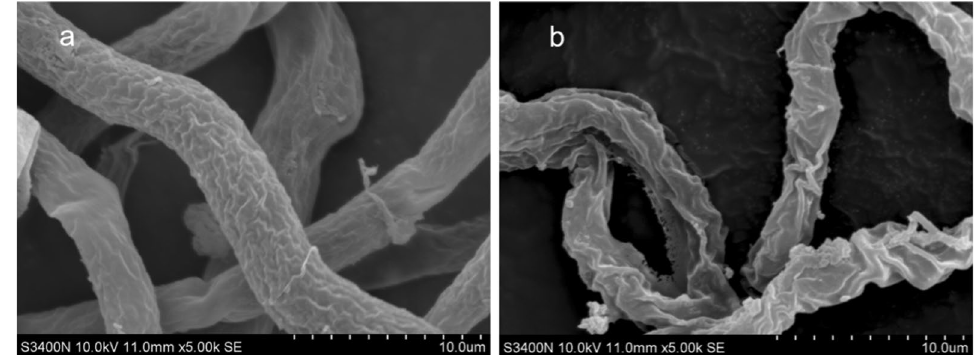
Fig. 5 The mycelial morphology of B. cinerea in the control group ( a ) and in the 4 EC 50 surfactin treatment groups ( b